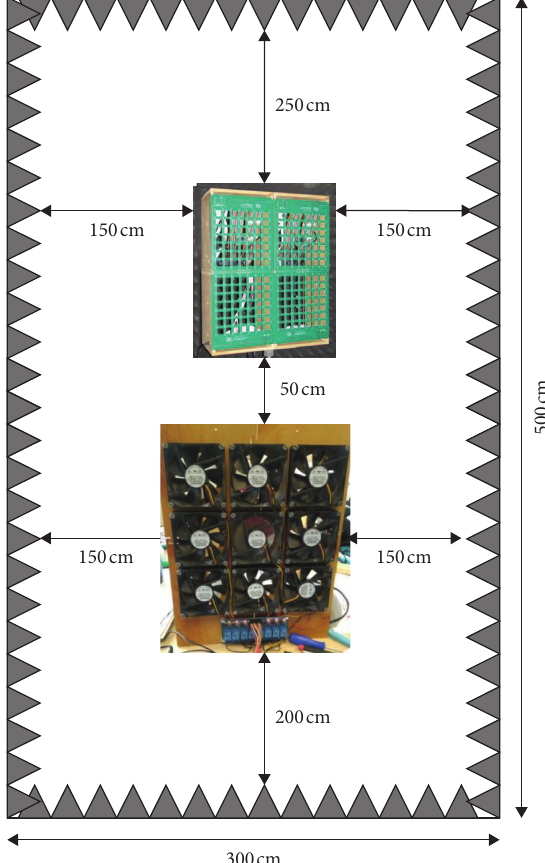
Figure 4: Experimental setup block